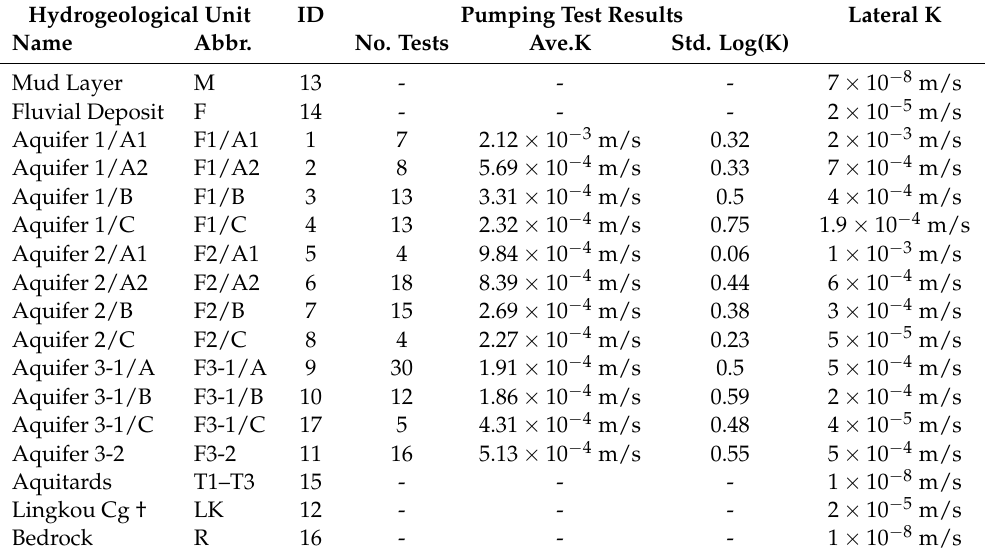
Table 1. Hydrogeological units in the PAP and associated hydraulic conductivity (K) values used on this study.